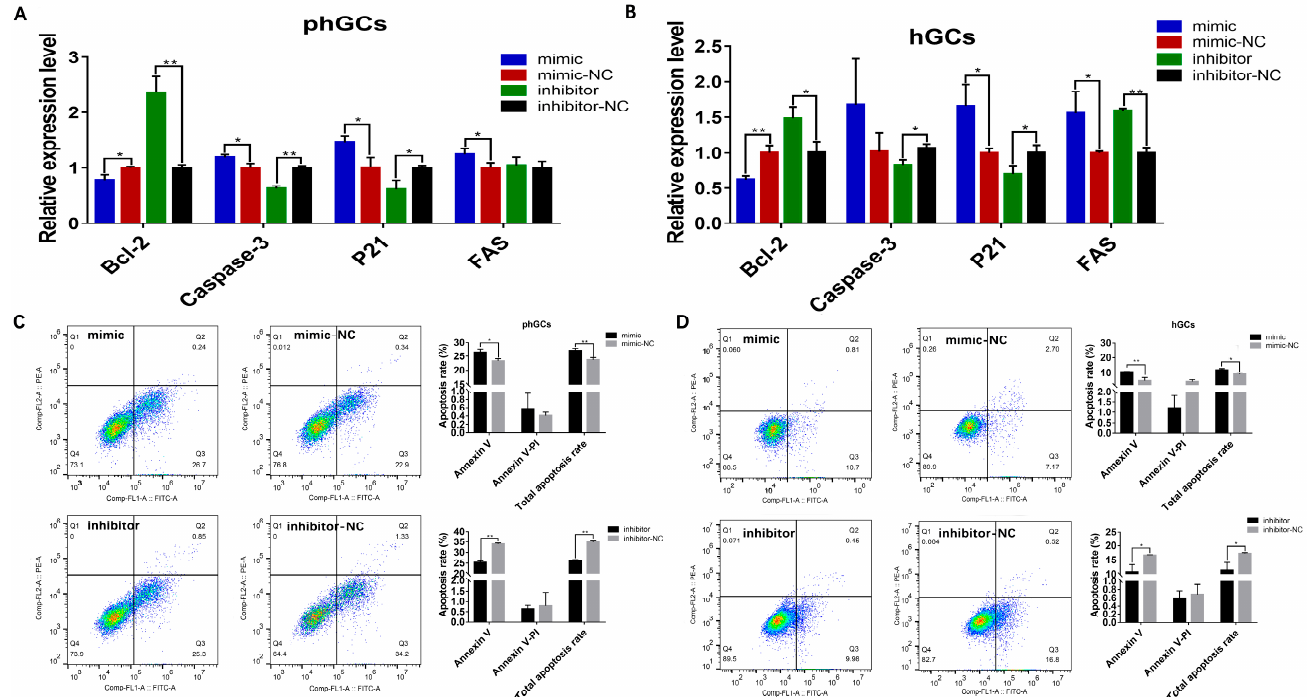
Figure 3. Effect of miR-202-5p overexpression/interference on the apoptosis of phGCs and hGCs. The relative expression of apoptosis–related genes in phGCs ( A ) and hGCs ( B ) (n = 3); apoptosis rates of phGCs ( C ) and hGCs ( D ) were determined by flow cytometer (n = 3). Data are means ± SD of technical replicates. * p < 0.05, ** p < 0.01.